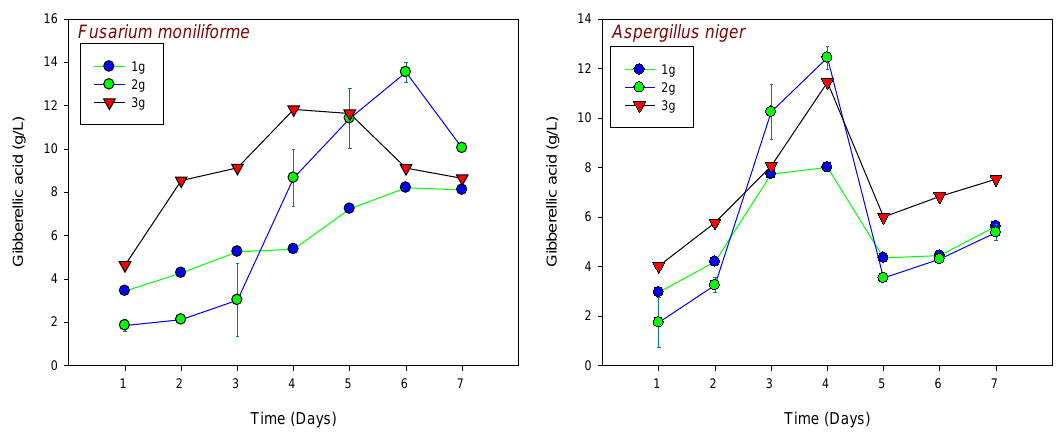
Fig. 4. Effect of varying substrate concentration on gibberellic acid yield using F. moniliforme and A. niger grown on banana peel as substrate Table 2. Gibberellic acid production by F. moniliforme and A. niger grown on banana peel supplemented with different concentrations of copper sulphate